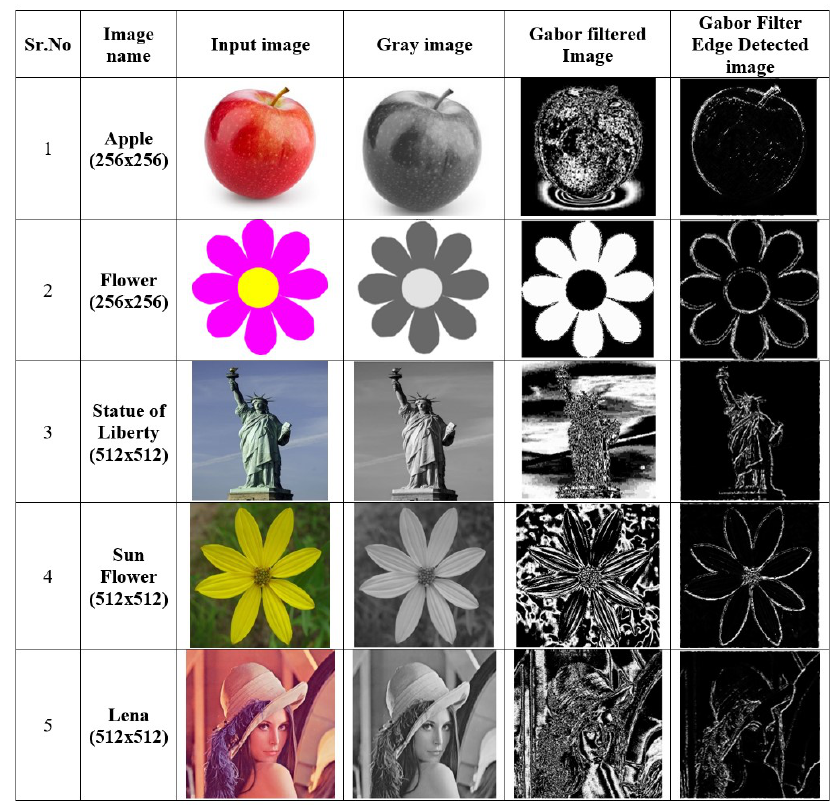
Figure 2. The Gabor filtered and edge detection outputs for various input images.